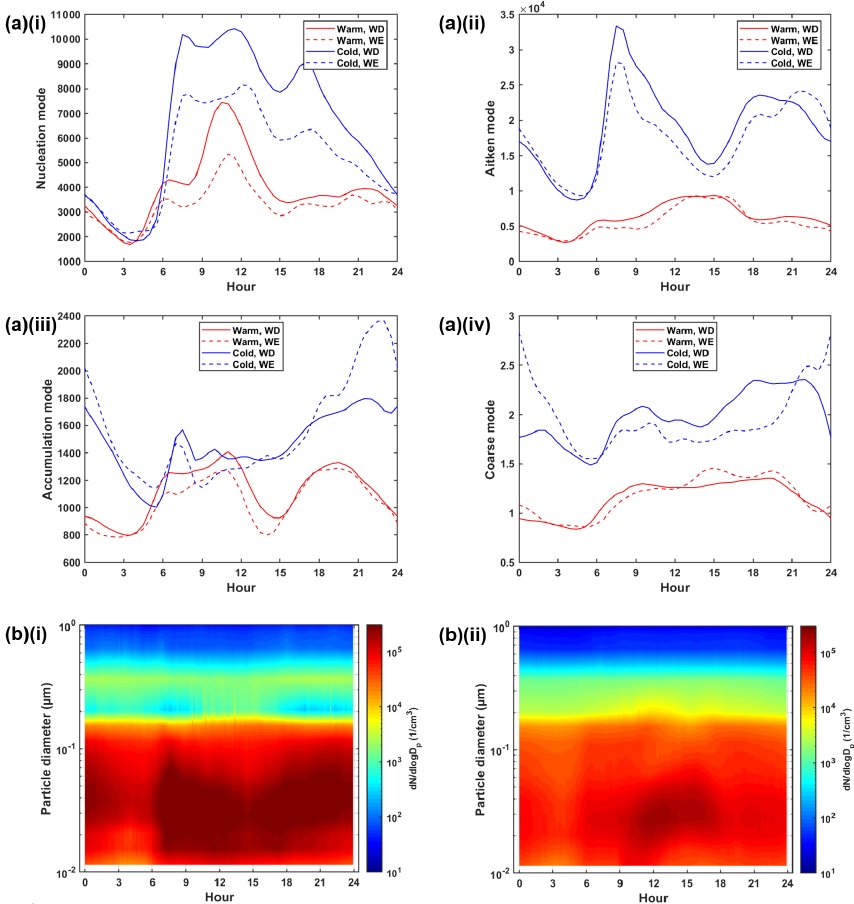
Figure 6. (a) Diurnal cycle of the (i) nucleation mode, (ii) Aitken mode, (iii) accumulation mode and (iv) coarse mode in warm (red) and cold months (blue) during workdays (solid) and weekends (dashed). (b) Particle size distribution in (i) cold and (ii) warm months, coloured by particle number concentration (cm − 3 ). Cold and warm months refer to December–February and June–August,